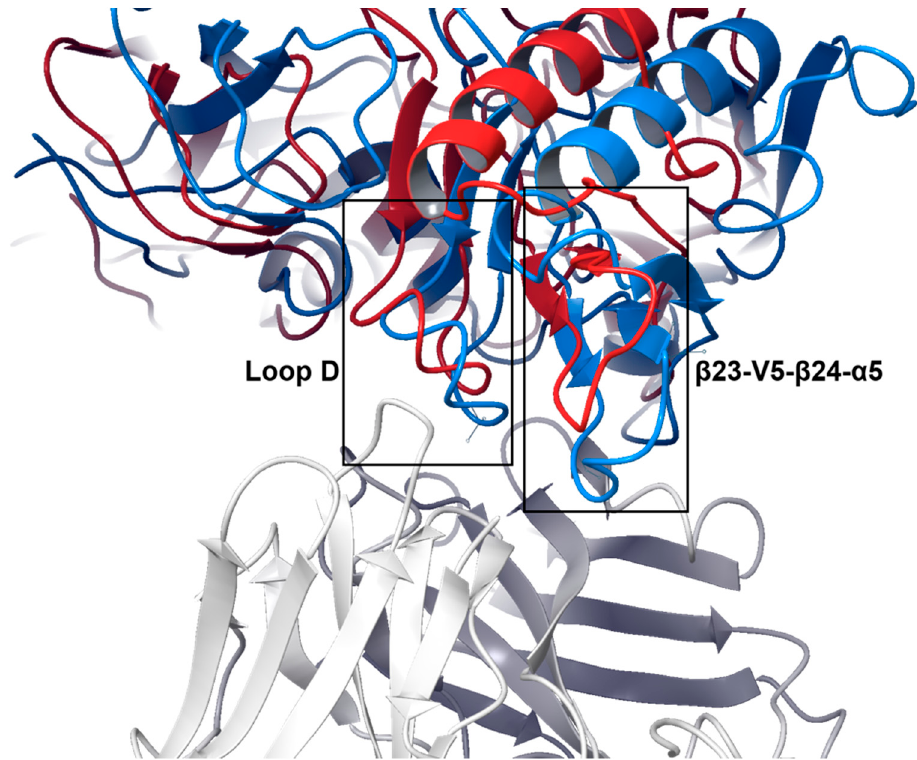
Figure 7. Representative binding mode of sensitive (Q482.d12, blue) and resistant (620345.c1, red) gp120 strains to VRC01. Depicted gp120 strains illustrate the representative structure of the maximum SASA frequency peaks of the PELE simulations (as shown in Figure 3). Analysis of the PELE predictions indicate that the antibody is unable to accommodate the loop D and the β 23-V5- β 24- α 5 region of the resistant gp120 strains.